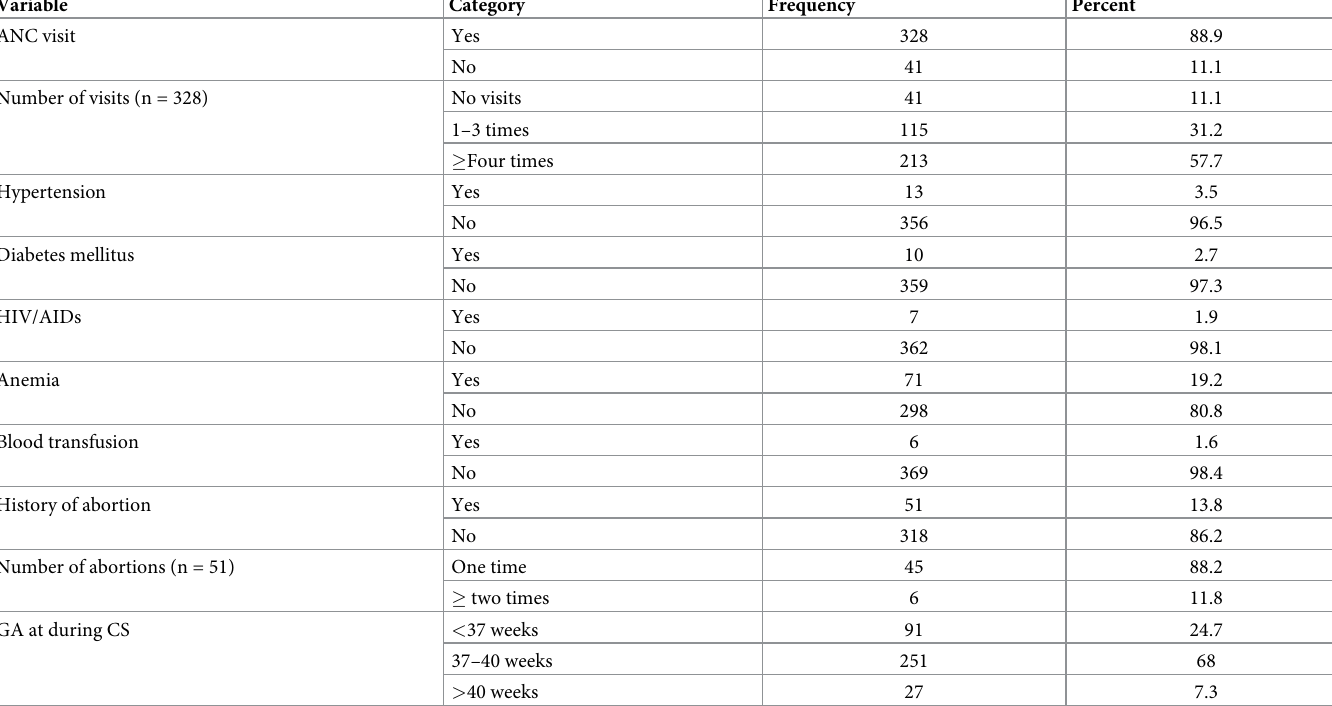
Table 2. Medical and obstetrics characteristics of the women on predictors of time-to-recovery from cesarean section delivery among women who gave birth by CS at HUCSH, 2020 (n = 369). Variable